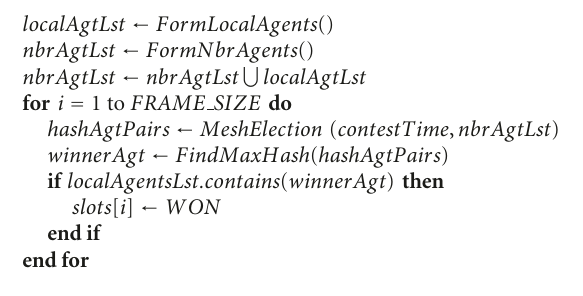
Algorithm 4: Scheduler